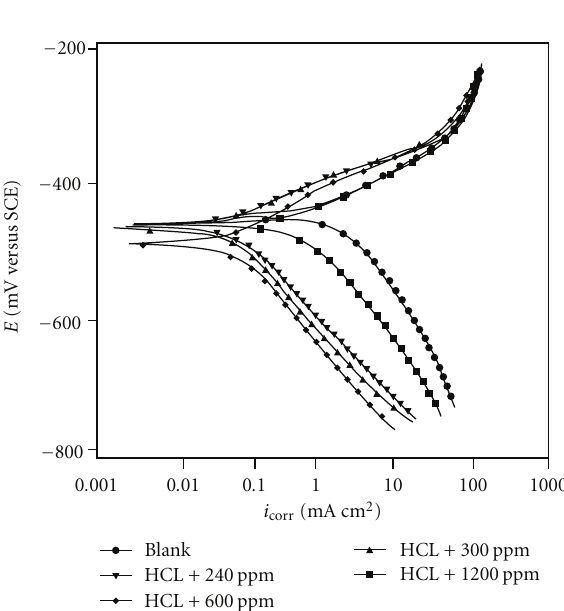
Figure 5: Polarization curves in absence and presence of di ff erent concentrations of extract in 1M